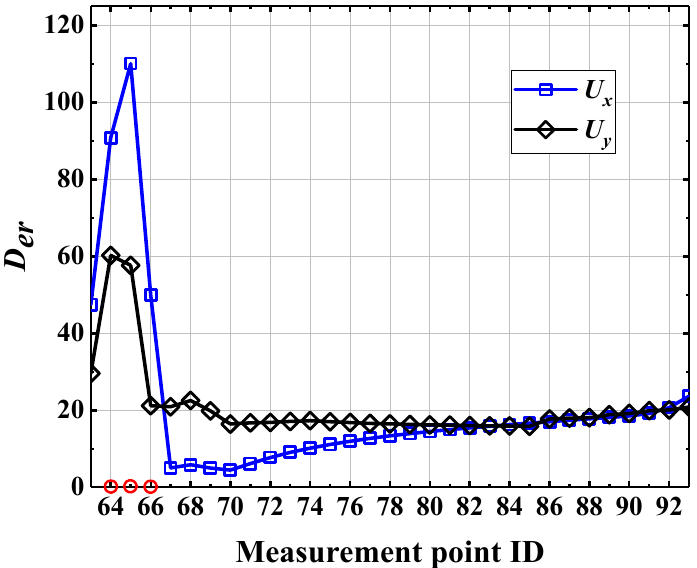
Figure 7. Displacement response of No. 63 measurement point under scenario 1: ( a ) U x ; ( b ) U y ; ( c ) Fourier spectrum.